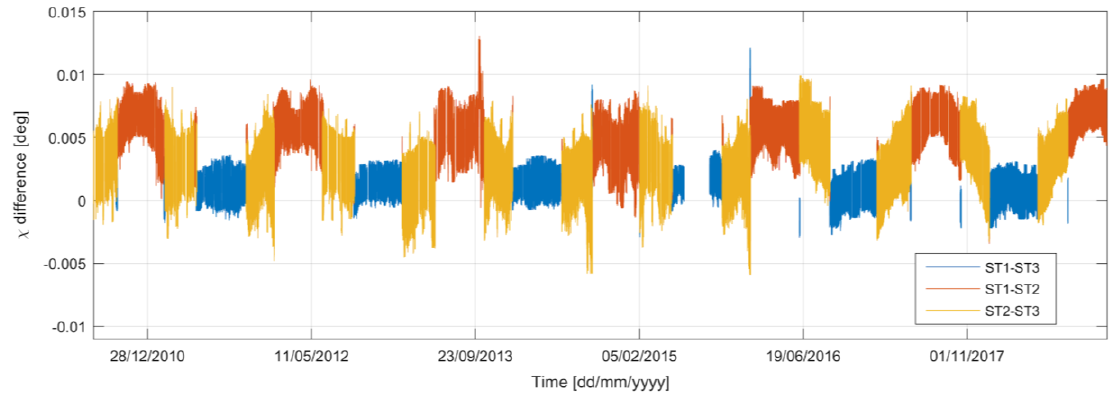
Figure 8. Roll difference for each Star Tracker pair. Blue represents differences between ST1 and ST3, yellow between ST2 and ST3, and red between ST1 and ST2.